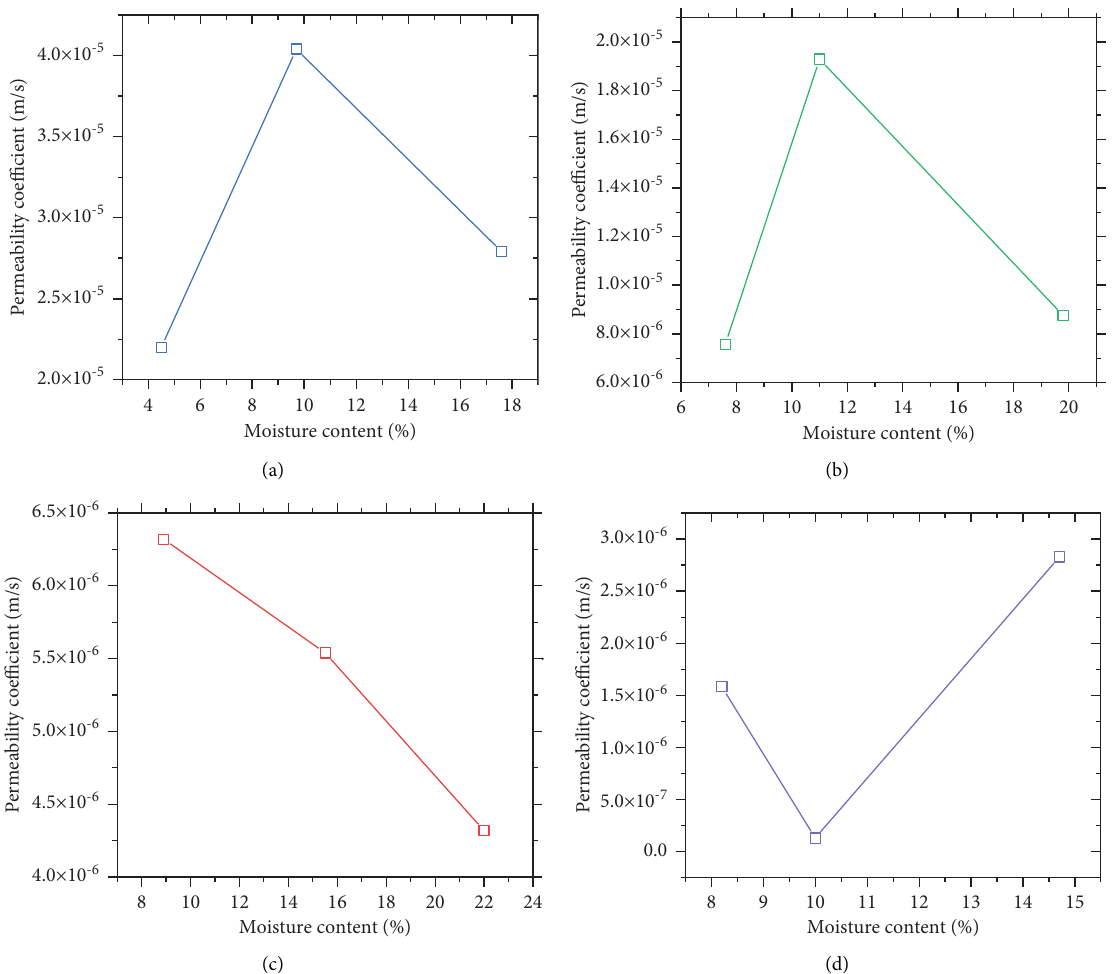
Figure 8: Relation curve between permeability coefficient and water content of the remolded loess. (a) Group RA. (b) Group RB. (c) Group RC. (d) Group